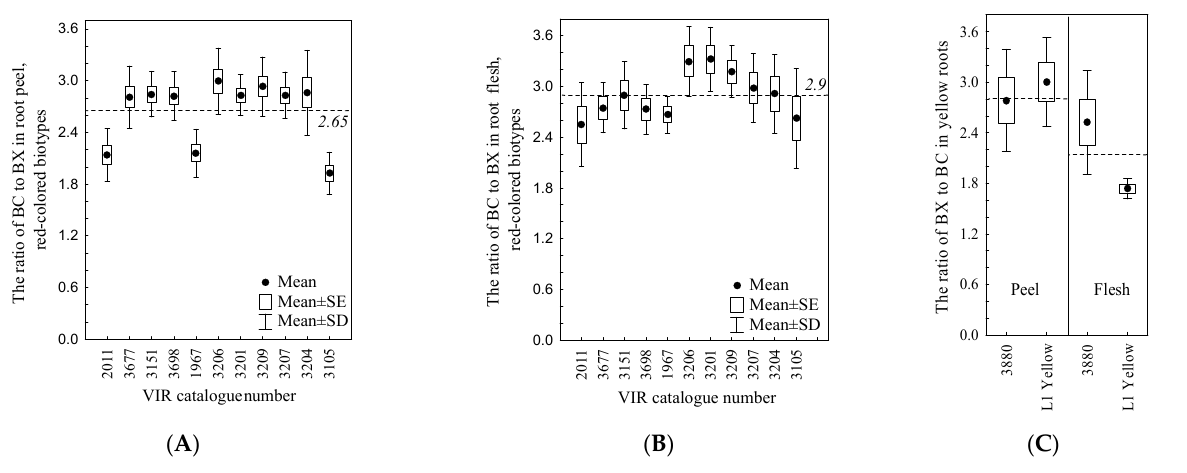
Figure 2. The BC/BX ratio in the peel ( A ) and flesh ( B ) of red-colored table beet accessions during the growing season. The BX/BC ratio in yellow-colored accessions ( C ).